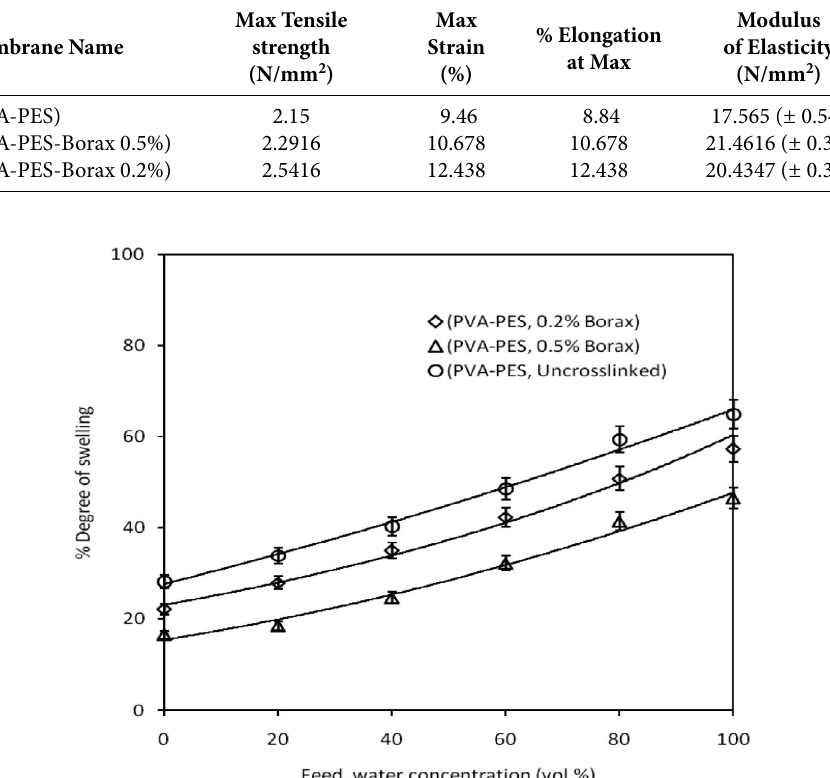
Fig. 8. Percentage degree of swelling as a function of feed water concentration at a constant